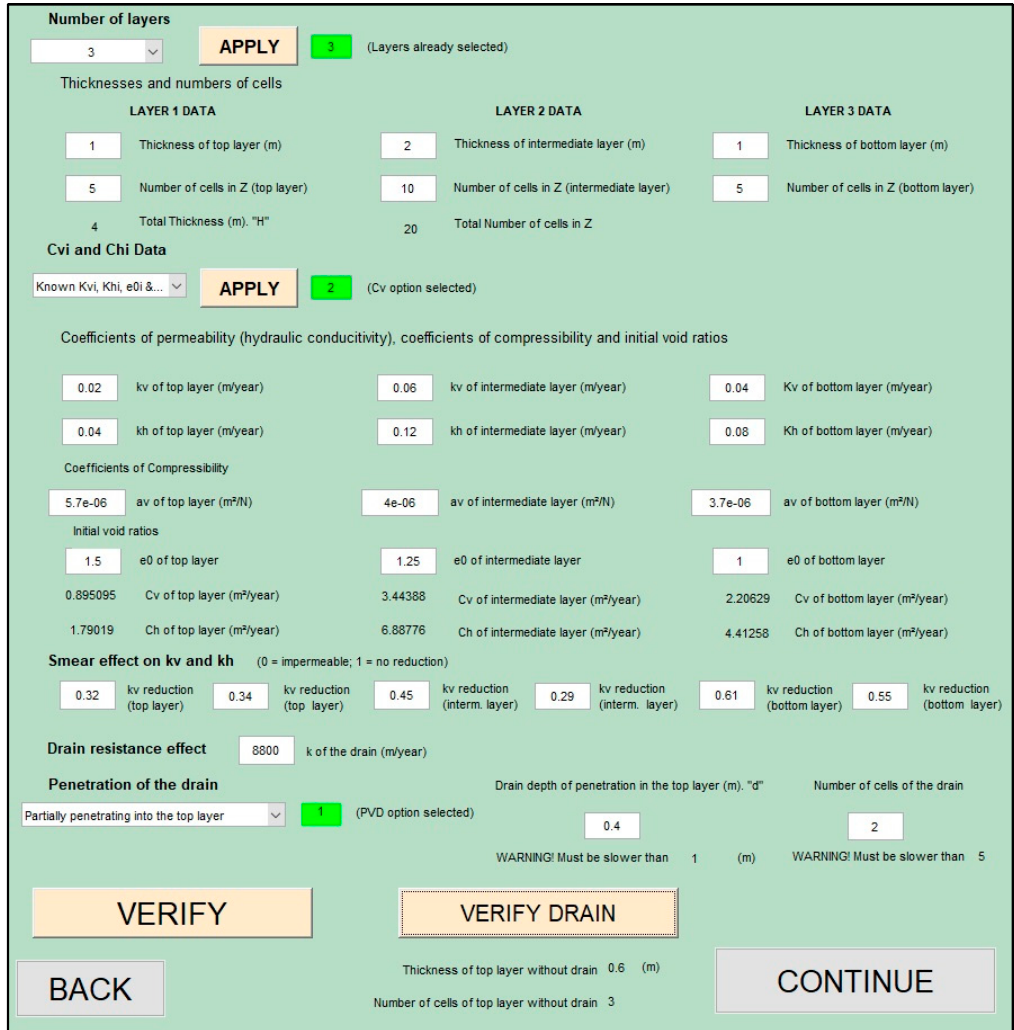
Figure 7. Second data entry screen.